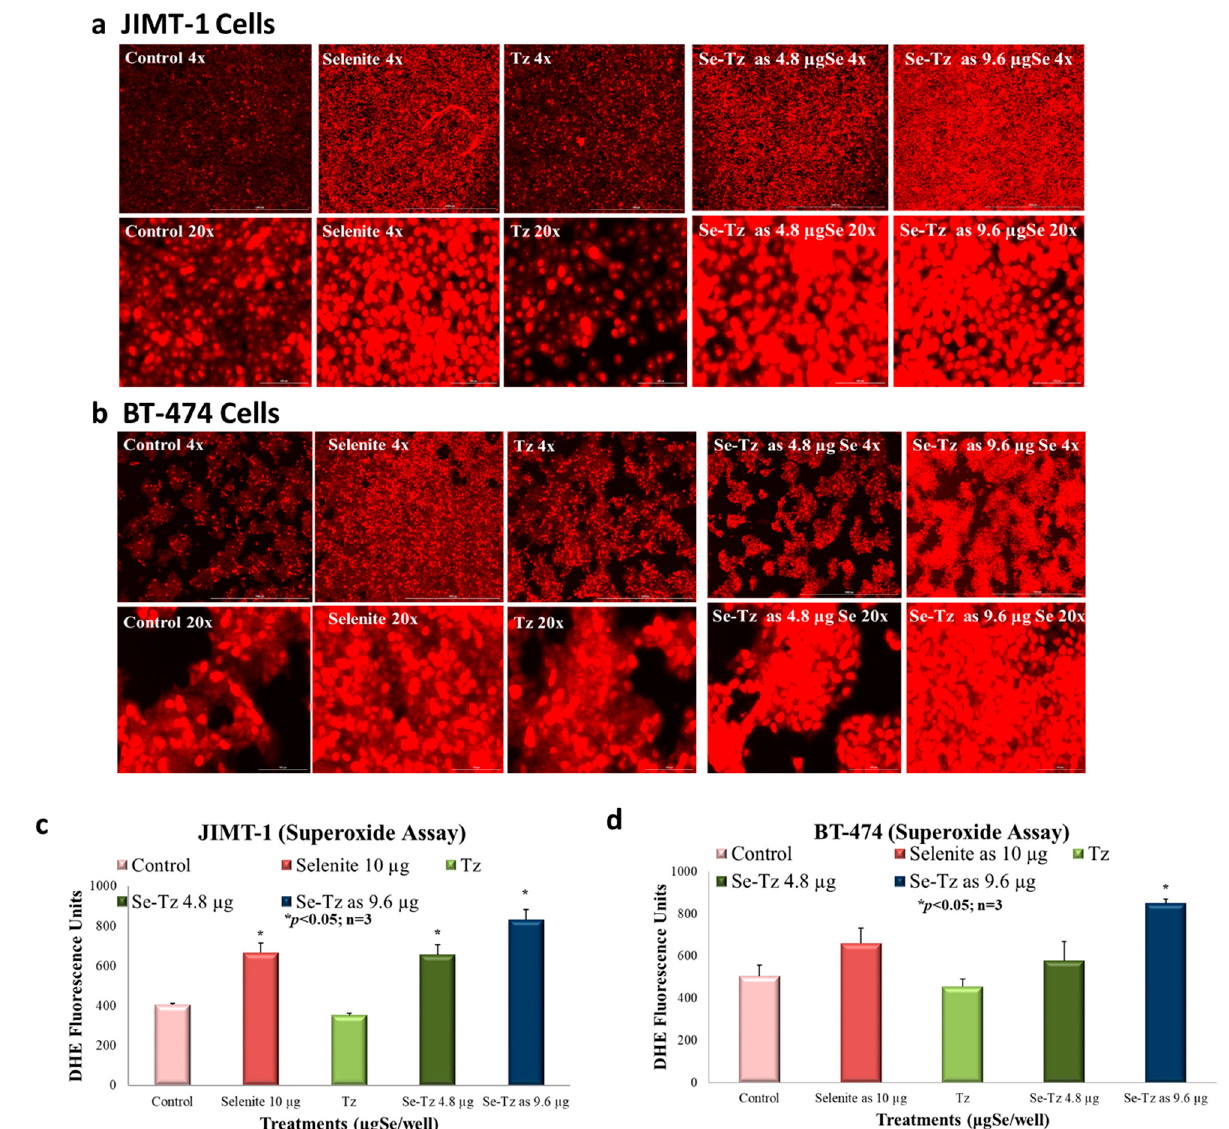
Figure 5. Superoxide Generation by Dihydroethidium (DHE) detection after selenium treatments. ( a , b ) Photographs of superoxide staining of JIMT-1 & BT-474 cells after Se treatments at magnifications of 4X= 1000 µ m; 20X= 100 µ m; ( c , d ) Quantitative measurement of superoxide generation of JIMT-1 & BT-474 cells after Se treatments. After acclimatization for 24 h, 50 units/well of SOD and 100 units/well of catalase were added to all wells in media. All cells, control, selenite, Tz and Se-Tz were appropriately treated and then DHE was added to the cells at a final concentration of 10 µ M in media. Selenite was used as a redox toxic positive control at a concentration of 10 µ gSe/well. Selenite at concentrations less than 10 µ gSe/well had no visible effect on cancer cell lines under these experimental conditions. The fluorescence was measured using a microtiter plate reader with an excitation at 520 nm and emission at 610